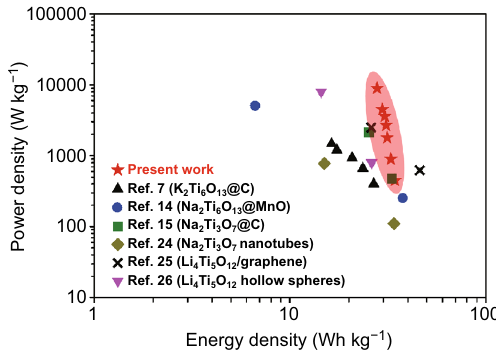
Fig. 8 Ragone plot correlating energy density and power density, in comparison with other recently reported supercapacitor devices using alkali metal